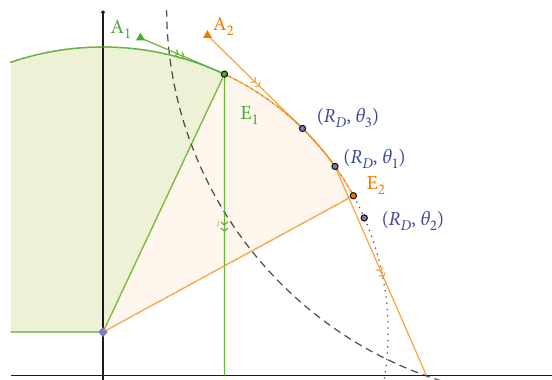
Figure 7: The optimal trajectories of the attacker with a sectorial detection